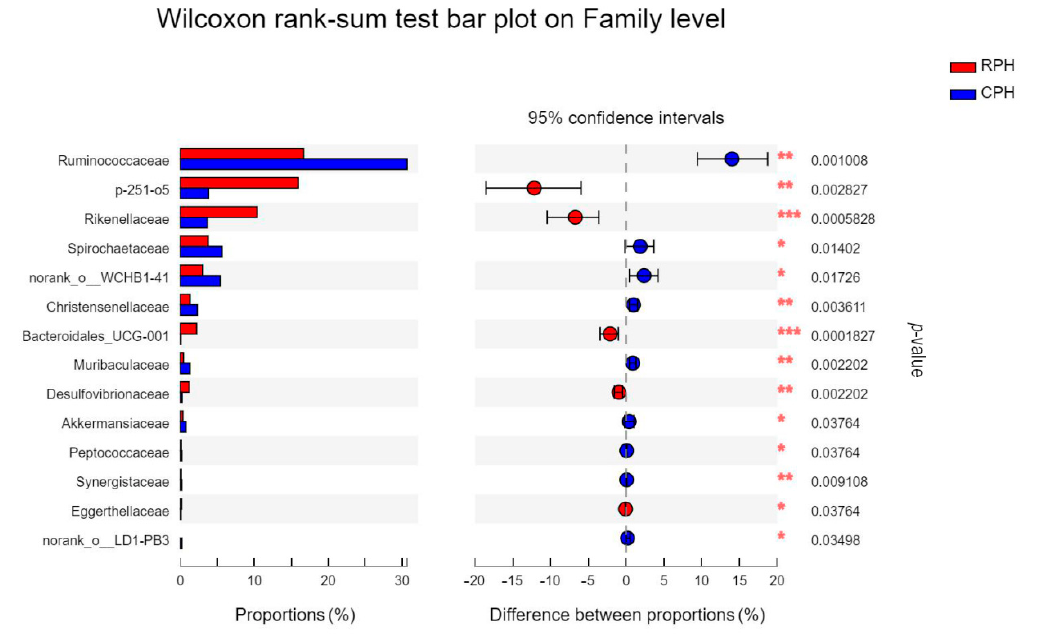
Figure 11. The bar plot shows the bacterial family with significant differences among the CPH and RPH. * p < 0.05, ** p < 0.01 and *** p < 0.001.